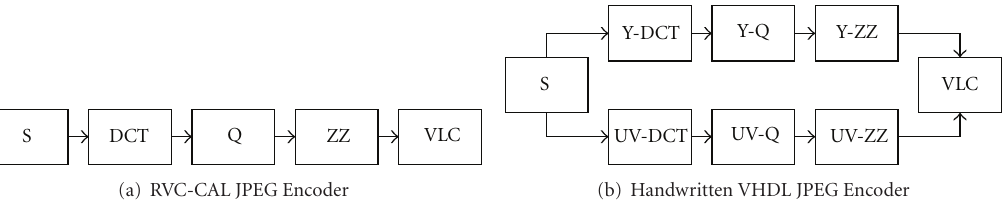
Figure 12: Description of the RVC-CAL and handwritten VHDL JPEG encoders.